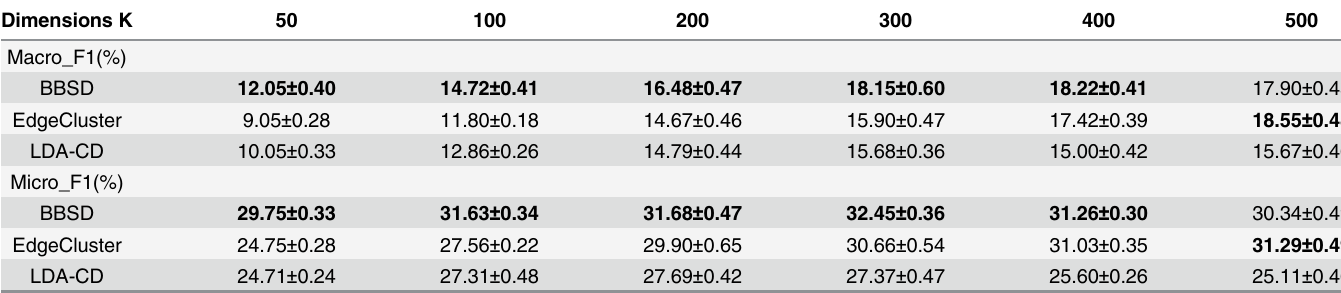
Table 4. Parameter sensitivity to social dimensions on Blogcatalog (LP = 50%).